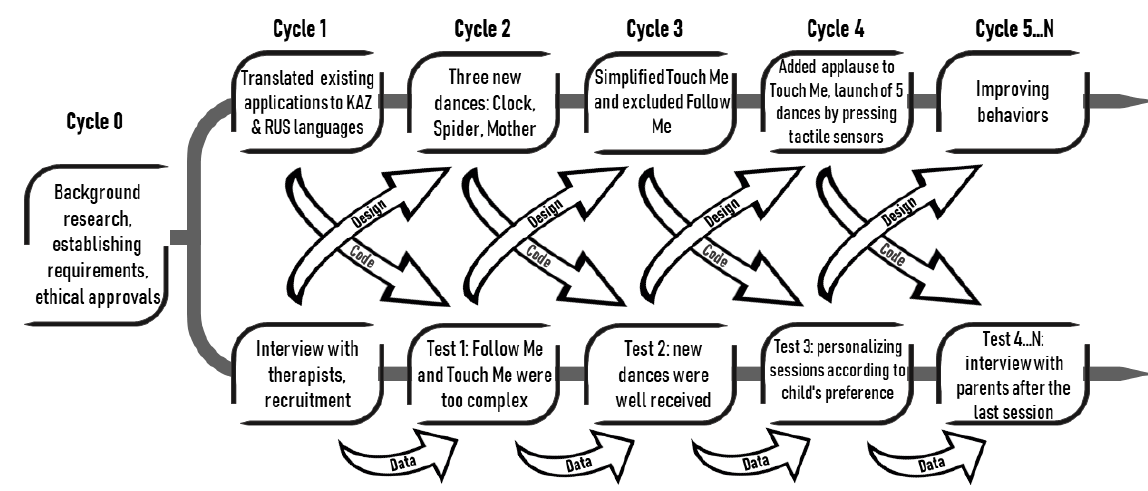
Figure 1: Iterative design flow of the proposed RAP